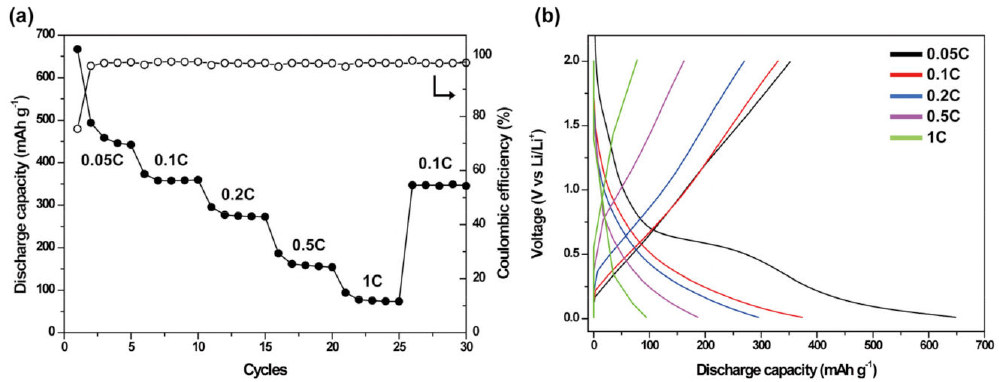
Figure 5. ( a ) Rate performance of the C-QWF electrode at a rate of 0.05 to 1 C-rate; ( b ) Galvanostatic discharge / charge voltage profiles of C-QWF between 0.01 and 2.00 V.